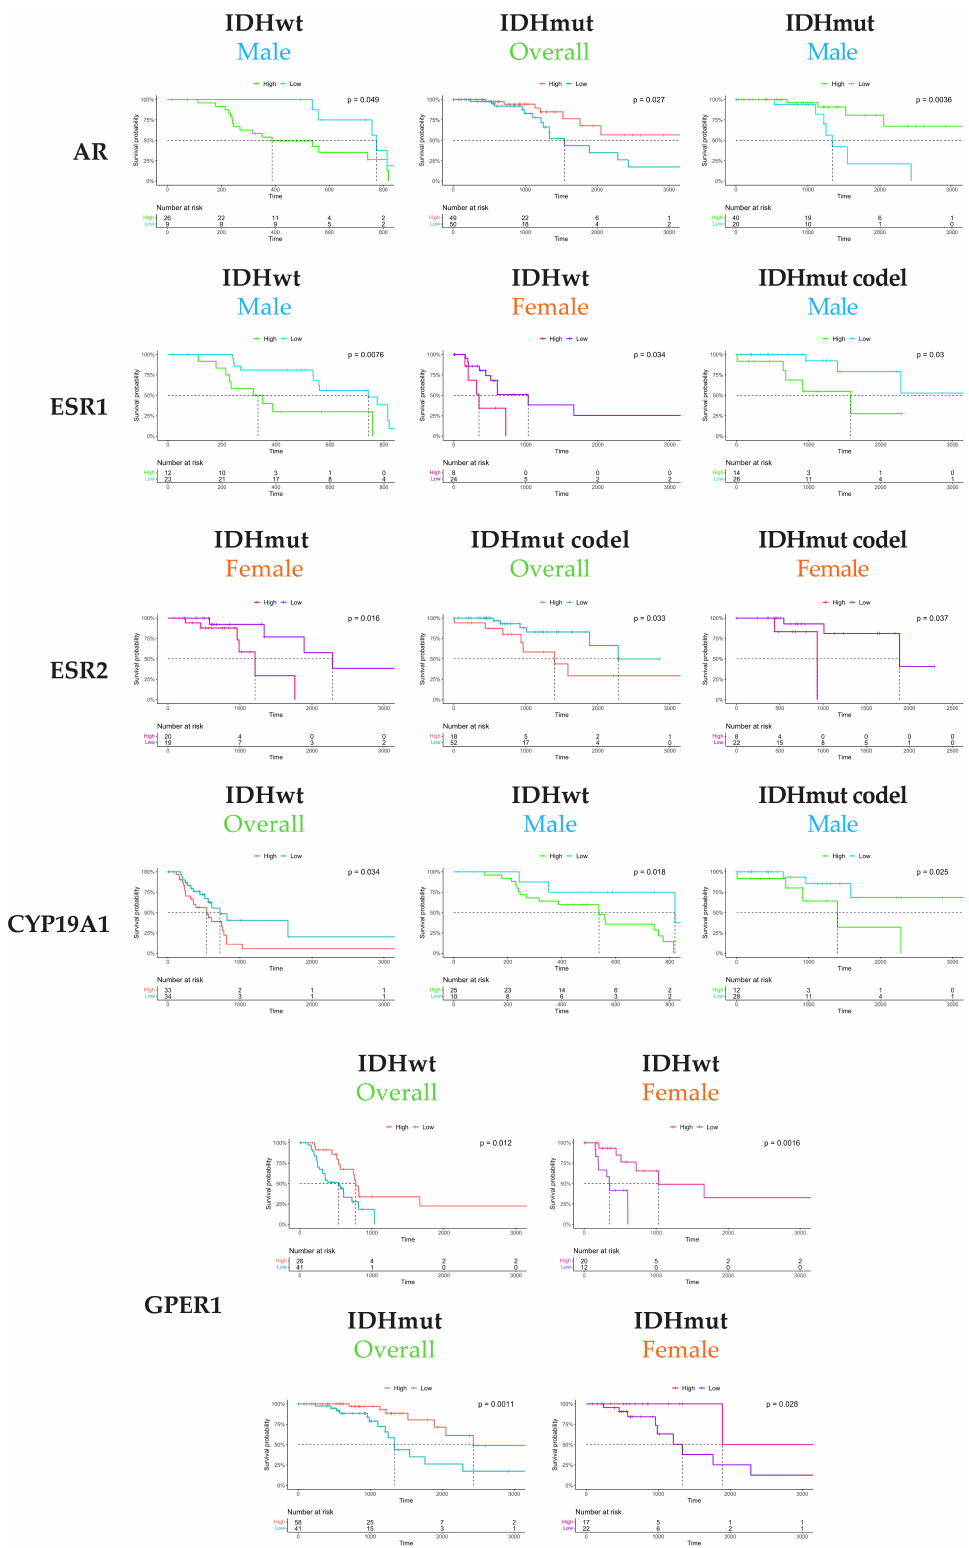
Figure 3. Kaplan–Meier survival curves of IDHwt, IDHmut, or IDHmut codel grade 3 patients (overall population, males, females) according to the expression of AR , ESR 1, ESR 2, CYP 19 A1 , and GPER 1. The curves were selected when corresponding gene expression was significantly associated to patient survival ( p < 0.05). The optimal cut-point was obtained by using the maximally selected rank statistics, with a minimum proportion of observations per group of